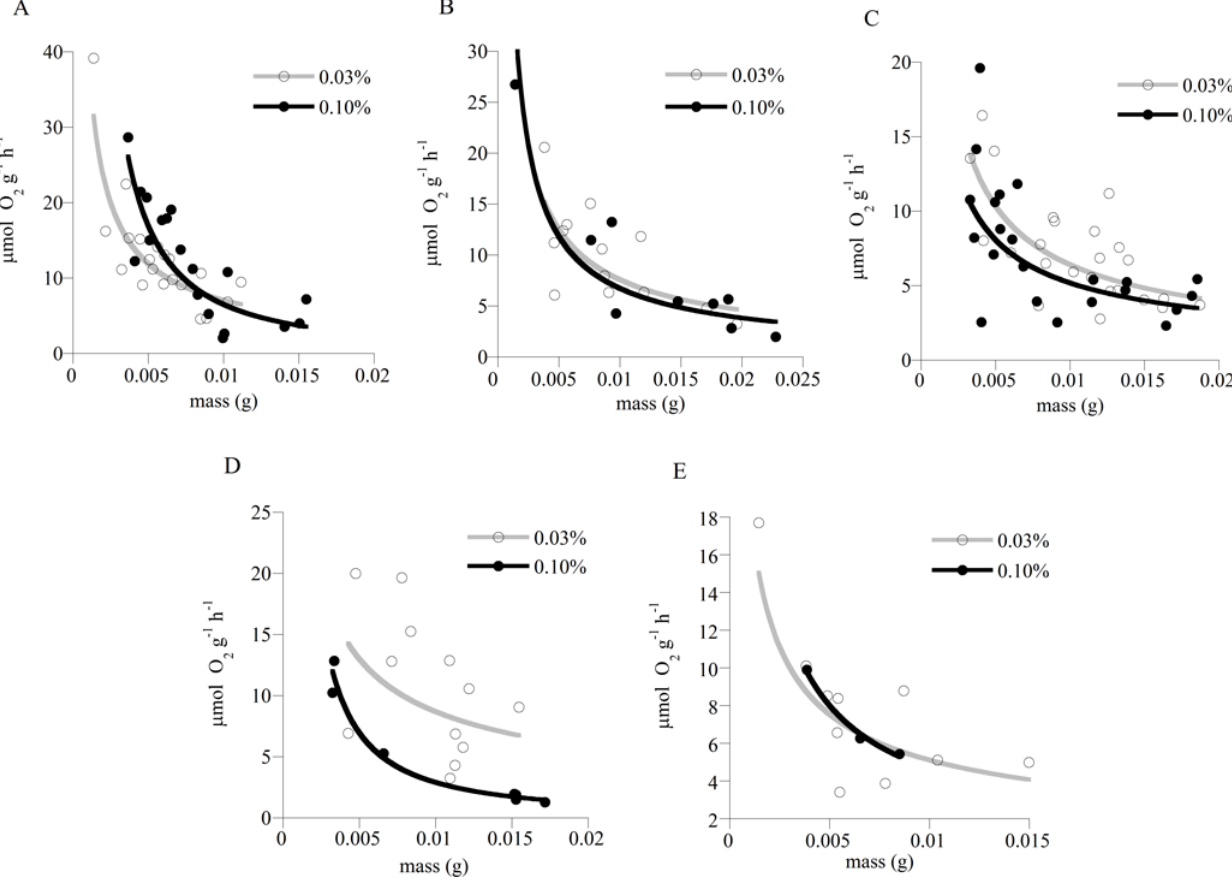
Fig. 2. Relationship between the oxygen consumption (µmolO 2 g − 1 h − 1 ) and mass ( g ) of thecosome pteropods (Table 3): (A) Cavolinia longirostris , (B) Clio pyramidata , (C) Hyalocylis striata , (D) Diacria quadridentata , and (E) Creseis virgula . Curves indicate normocapnic (0.03%, grey) and hypercapnic (0.10%, black)